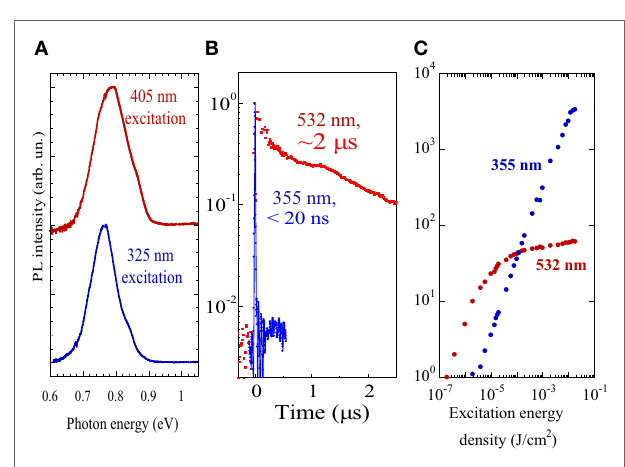
FiGURe 13 | (A) Normalized low-temperature PL spectra (shifted vertically for clarity) collected for different excitation wavelengths. (B) The PL decays measured at 0.78 eV under ~6 ns duration pulsed excitation with the indicated excitation wavelengths. (C) The PL intensity as a function of excitation energy density at different excitation wavelengths. During these measurements, the sample temperature was 15 K (Modi et al.,